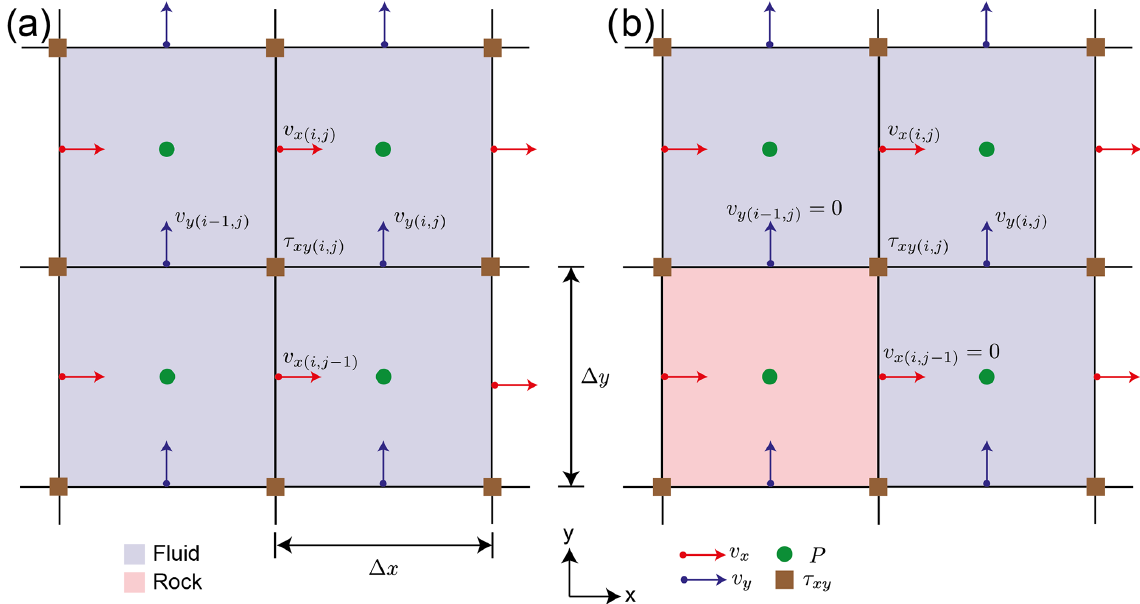
Figure 2. Staggered-grid stencil rescaling. (a) Stencil without interfaces and (b) with solid interfaces. The sketch is based on a cross section of Fig. 1 in the x – y